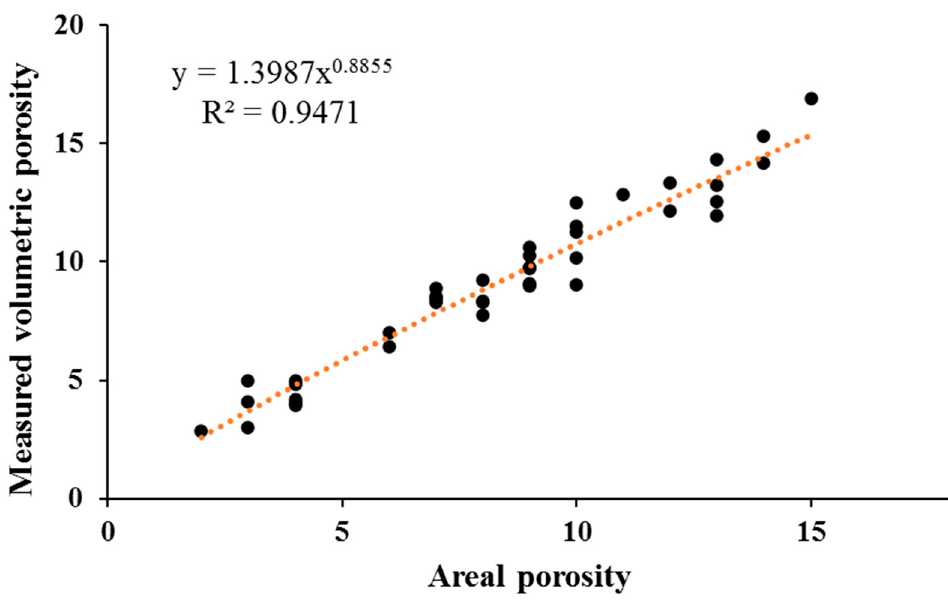
Figure 6. The cross plots of plane porosity versus volumetric porosity for the Lower Shihezi Formation sandstone in the Duguijiahan block. Table 2. The porosity evolution of the Lower Shihezi Formation sandstones.